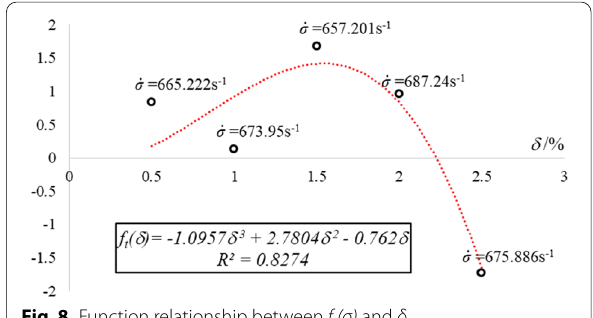
Fig. 8 Function relationship between f t (σ) and δ